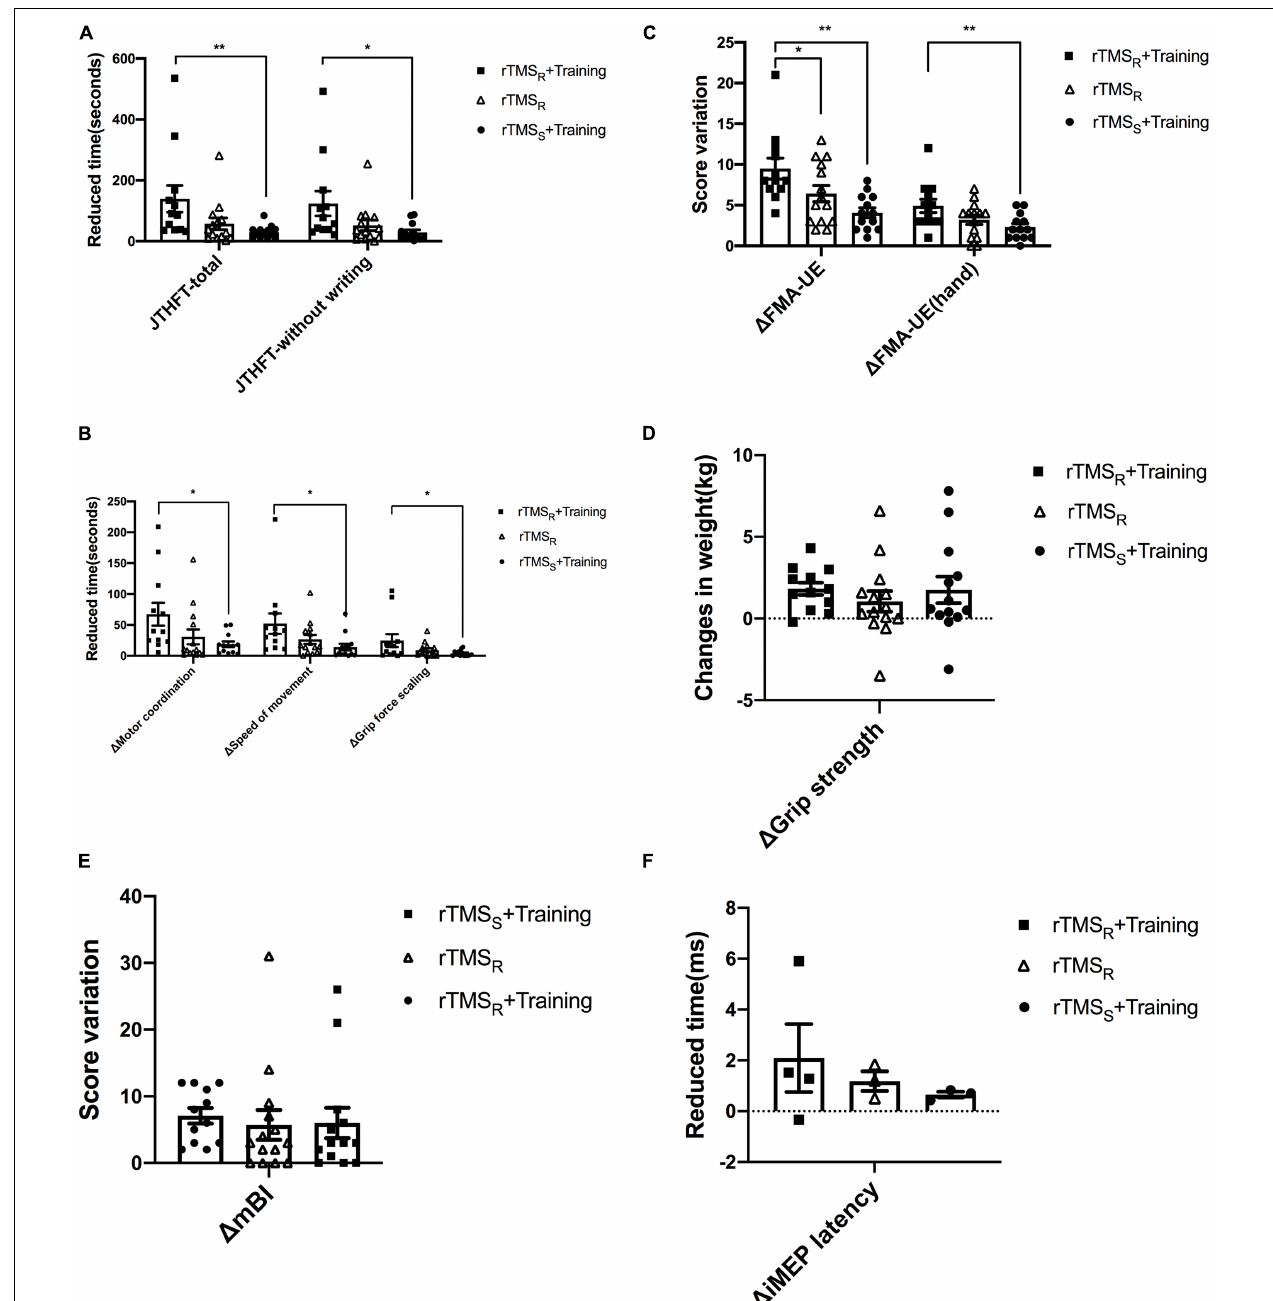
FIGURE 2 | Behavioral and neurophysiological changes among the three groups (mean ± SEM). rTMS R +Training: rTMS and hand grip training (Group A); rTMS R : rTMS alone (Group B); rTMS S +Training: hand grip training alone (Group C). rTMS: repetitive transcranial magnetic stimulation. One-way ANOVA or nonparametric Kruskal–Wallis H test was used to compare the behavioral and neurophysiological changes among the three groups, and multiple comparisons with the whole pairwise comparation. * p < 0.05, ** p <